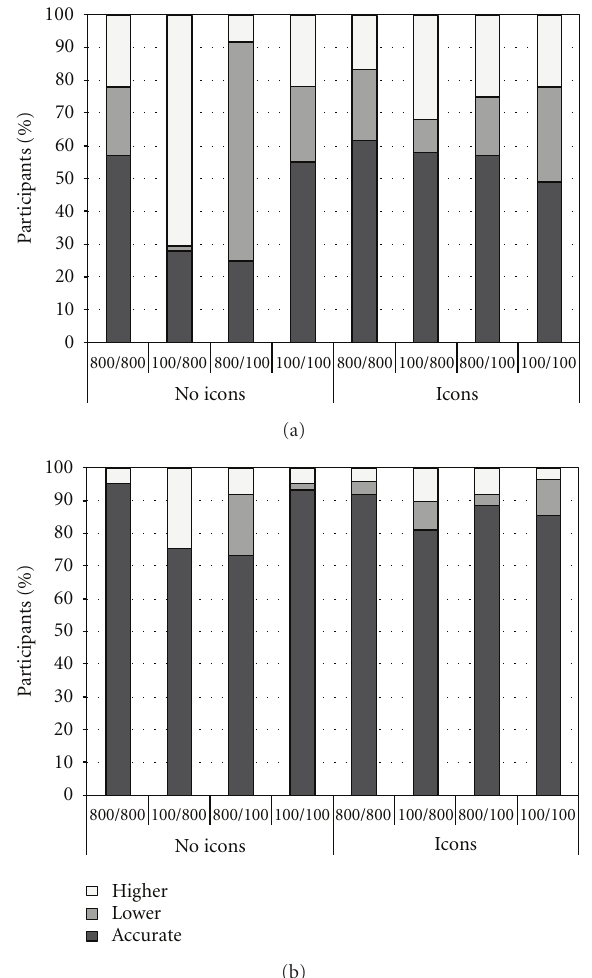
Figure 2: (a) Percentage of participants with low numeracy whose estimates of risk reduction were accurate, lower, or higher than the exact value as a function of the sizes of the denominators and icon arrays. (b) Percentage of participants with high numeracy whose estimates of risk reduction were accurate, lower, or higher than the exact value as a function of the sizes of the denominators and icon